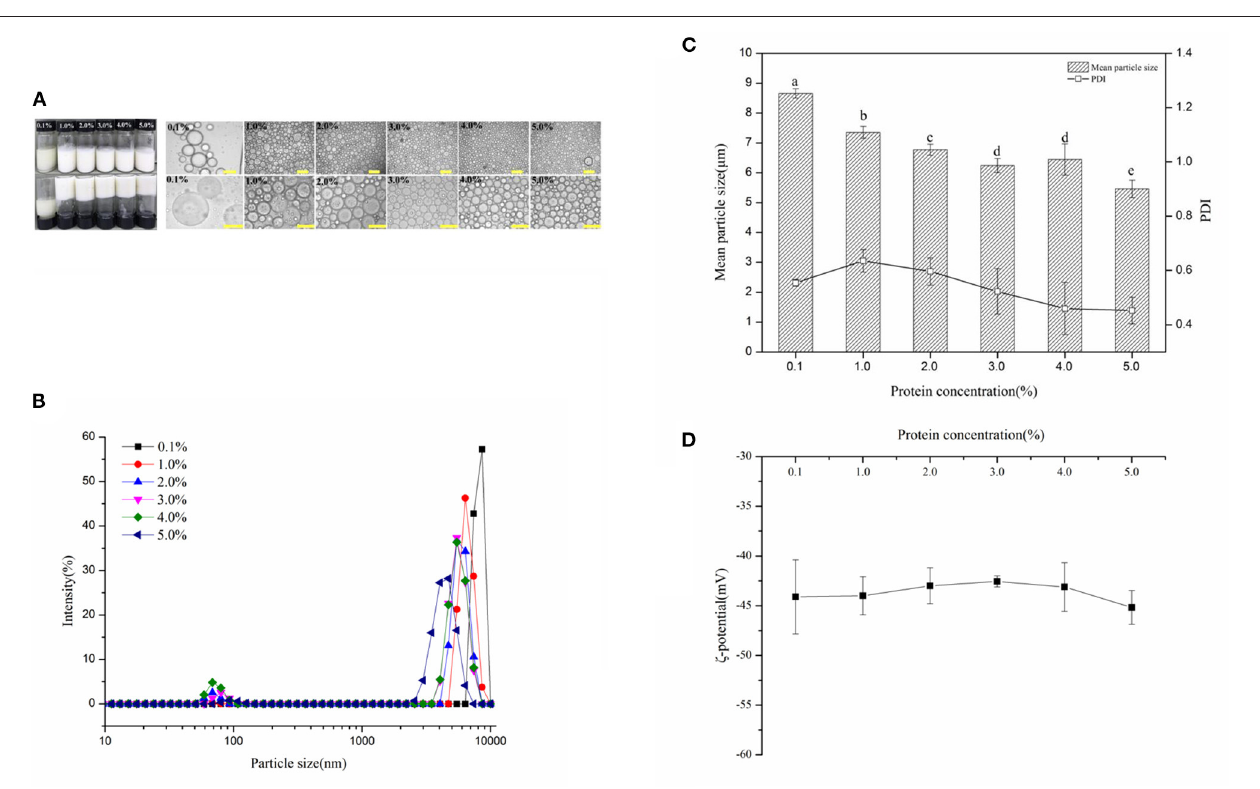
FIGURE 2 | (A) Visual appearance and optical micrographs of fresh WSP-stabilized high internal phase emulsions (HIPEs) (oil fraction, φ = 75%), at varying protein concentration c values of 0.1, 1, 2, 3, 4, and 5%, respectively. The scale bars are 100 and 50 µ m, respectively. (B) The distribution of the HIPE droplet size in the aqueous phase with varying protein concentrations. The mean particle sizes and polydispersity indexes (PDI) (C) and ζ -potential (D) of HIPEs prepared by WSP (0.1, 1, 2, 3, 4, and 5 wt%). Different letters (a, b, c, d, e) in the same column indicate significant differences ( p < 0.05.)